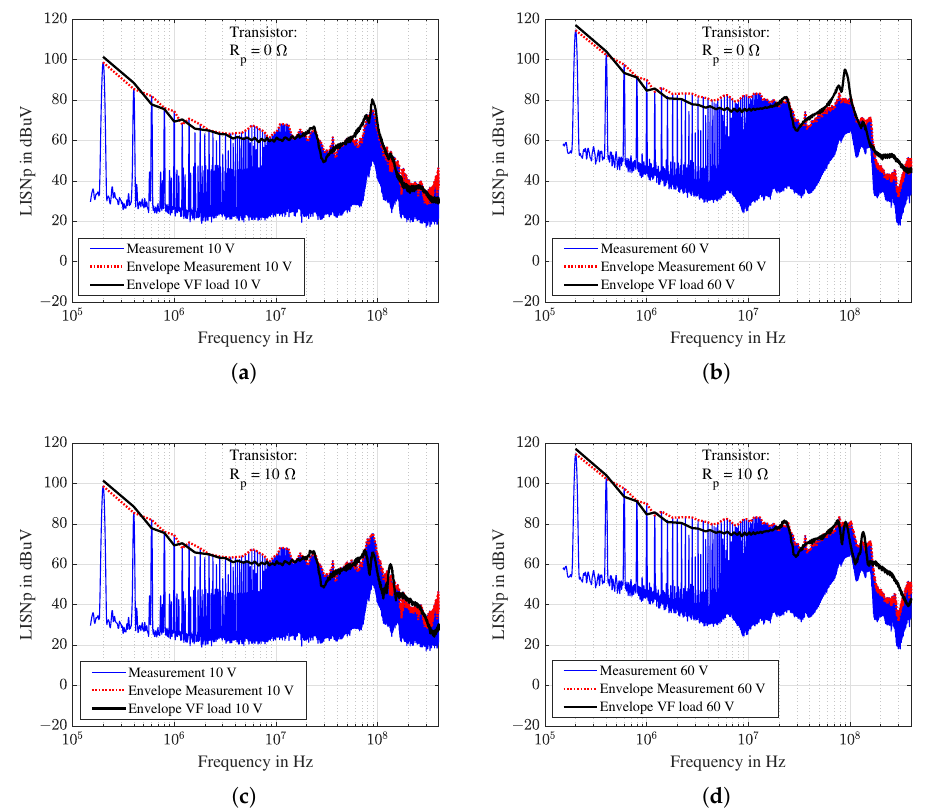
Figure 26. Comparison between measured and simulated conducted emissions with V DC = 10 V and V DC = 60 V. ( a , b ) VF load model and R p = 0 Ω . ( c , d ) VF load model and R p = 10 Ω